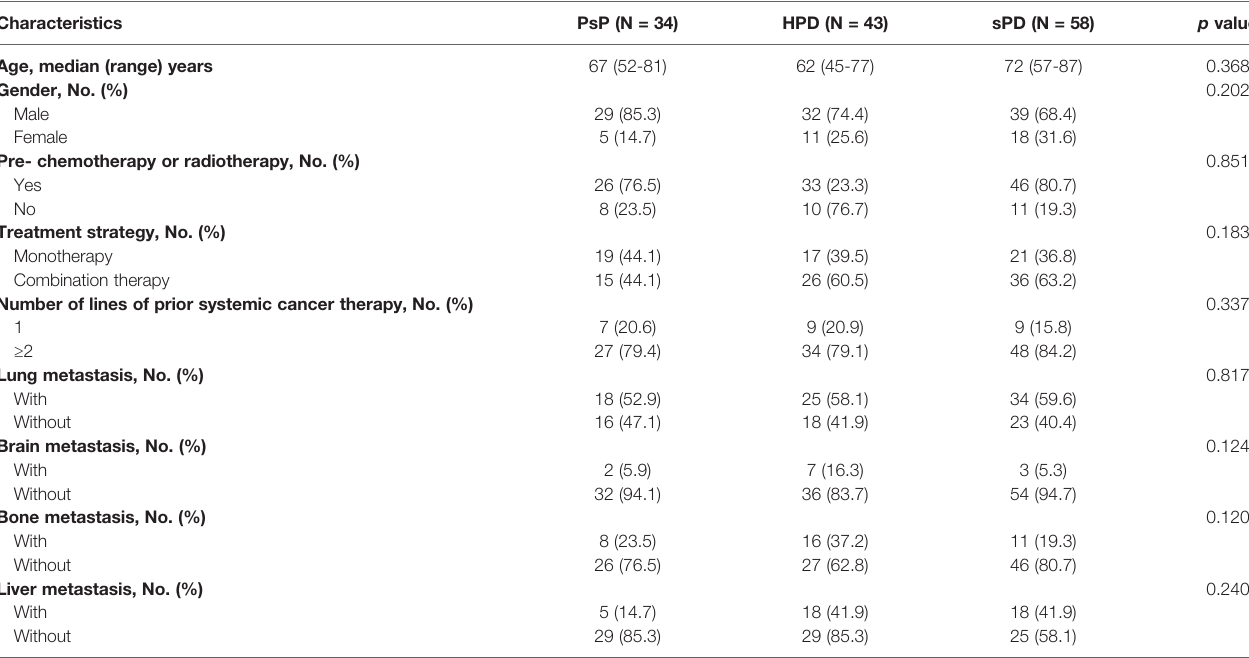
TABLE 1 | Baseline characteristics of 135